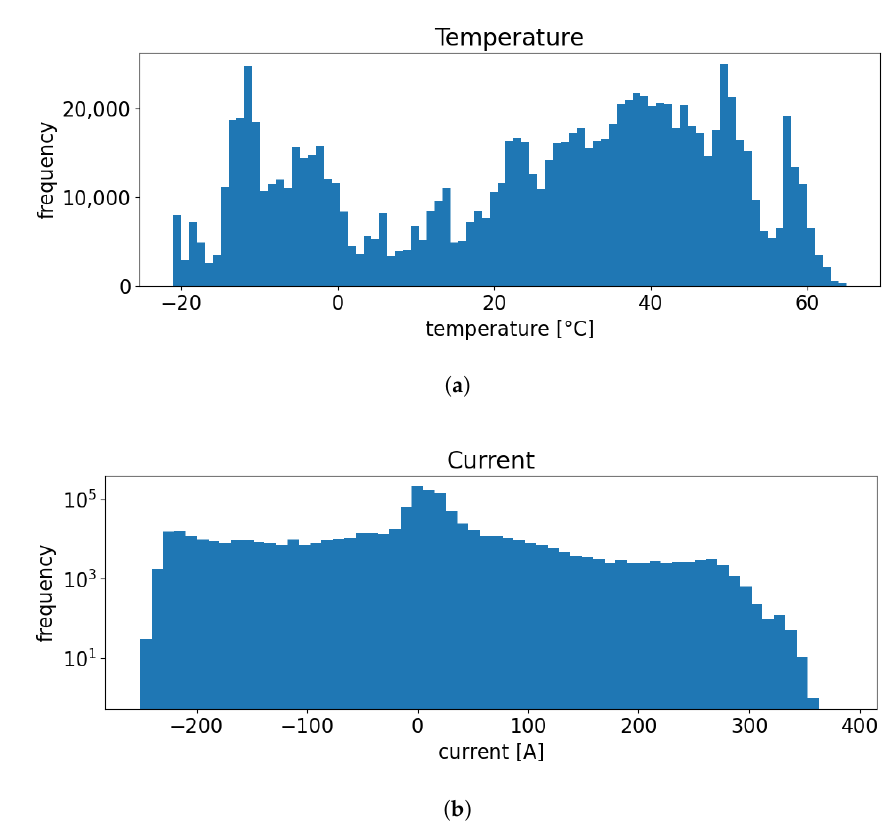
Figure 2. Training data distribution of ( a ) temperature and ( b ) current after over- and